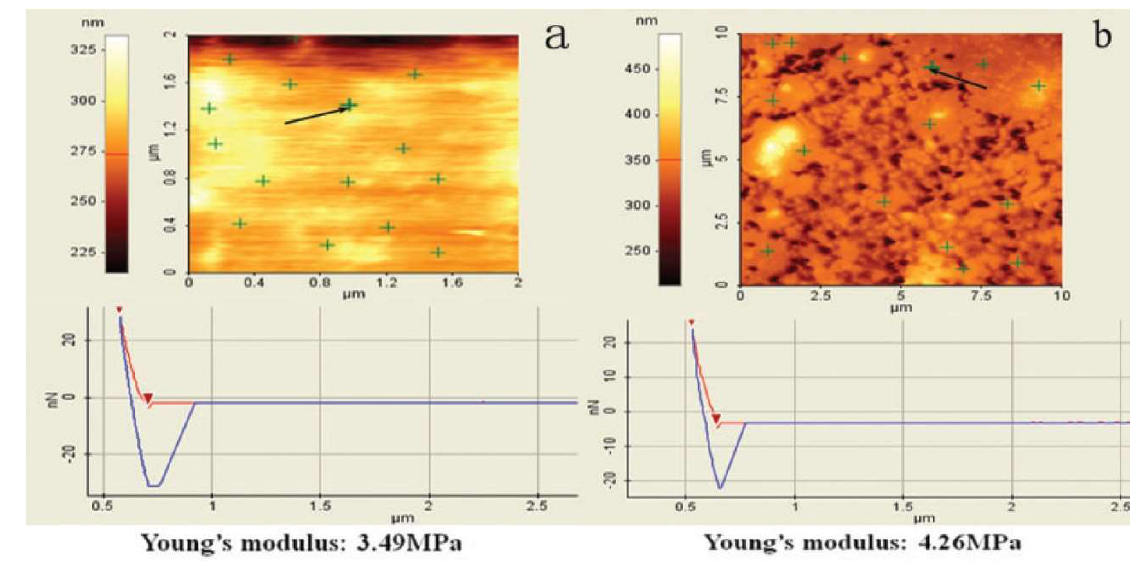
Figure 20. Young’s modulus calculation results of ENR50: ( a ) pure cured ENR50, and; ( b ) ENR50 in EPDM/ENR50 (75/25) blend [55].